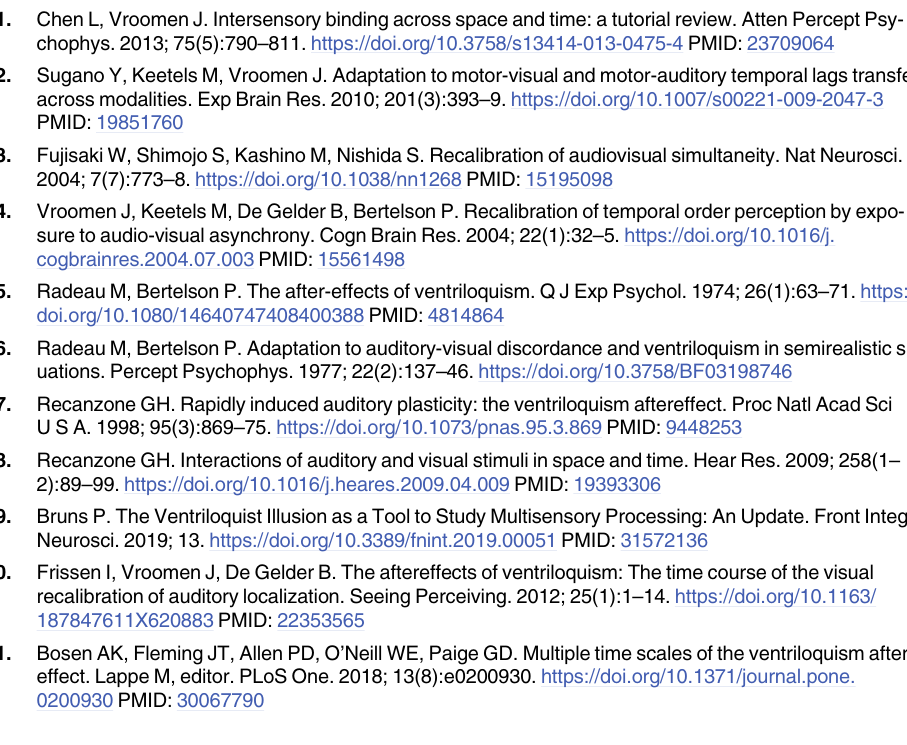
errors of the coefficients. (b) VAE magnitudes and gain differences, quantified by contrasting spatial bias and gain coefficients between adaptation disparities (-20˚ > +20˚). Values are shown for both constant (blue; Experiment 1: eye+head-consistent condition) and variable disparities (pink; Experiment 2). Positive VAE magnitudes indicate spatial recalibration in the direction of the mean visual offset. Error bars indicate standard